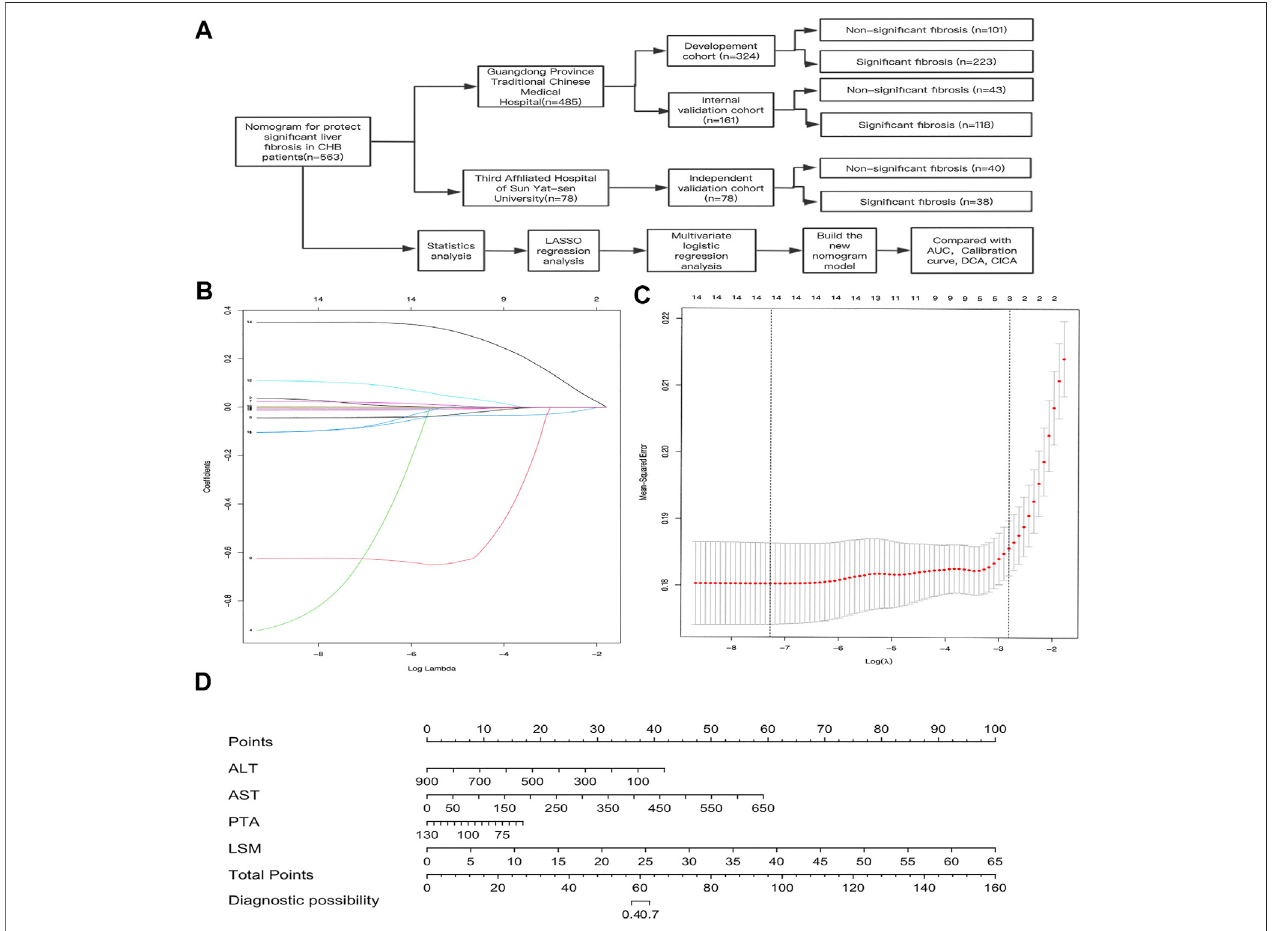
FIGURE 1 | Construction of the AAPL nomogram (ALT, AST, PTA, and LSM) for predicting signi fi cant liver fi brosis in patients with CHB. (A) Flowchart of the study sample and AAPL nomogram construction. (B) Selection of fundamental clinical indicators using least absolute shrinkage and selection operator (LASSO) regression analysis. (C) Cross-validation plot for the penalty term. (D) AAPL nomogram for predicting signi fi cant fi brosis in patients with CHB.